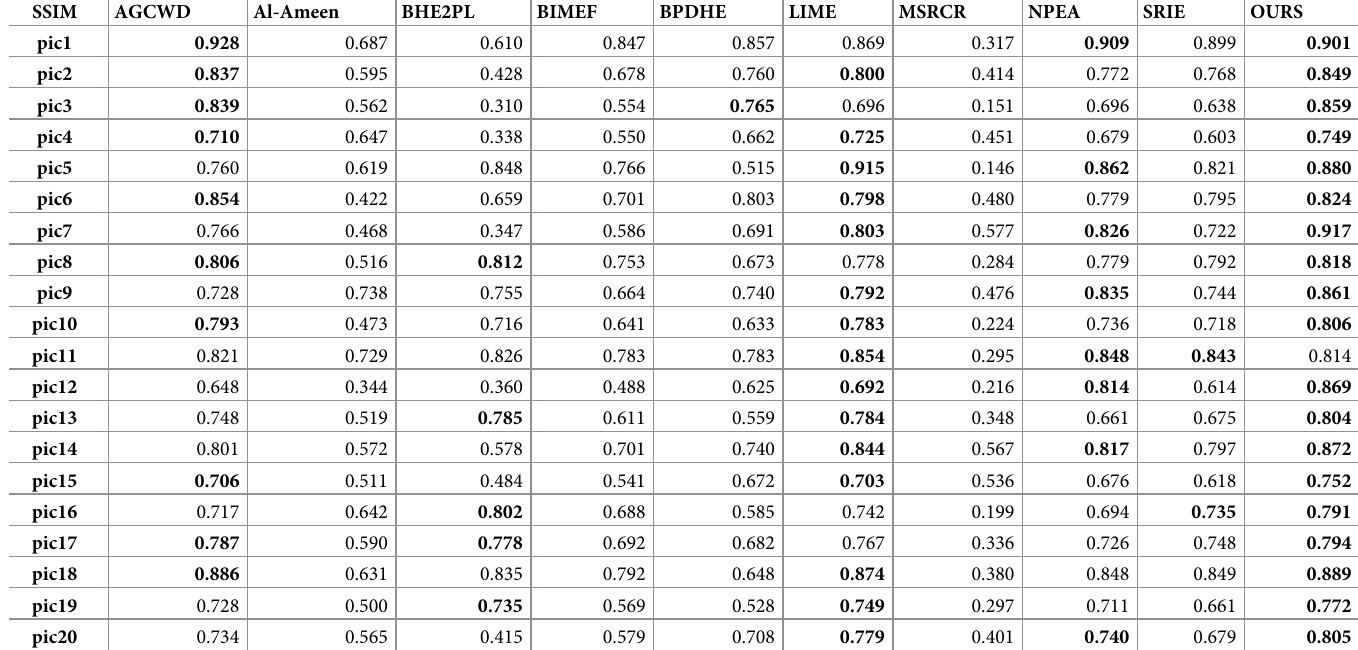
Table 5. SSIM values of 20 random images of MIT-5K.